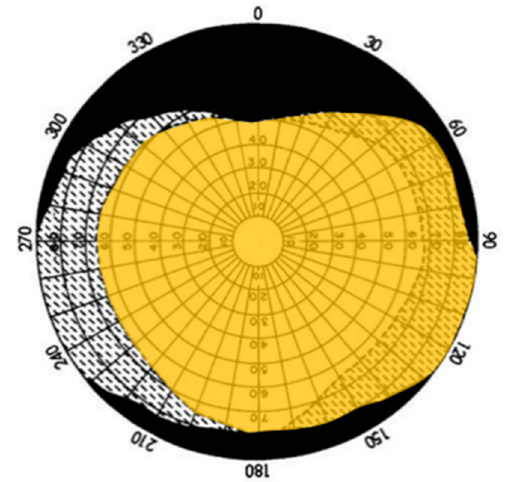
Figure A2. The human visual field [18] for indoor photopic binocular vision. Yellow area for the right eye is 16,200 deg 2 .